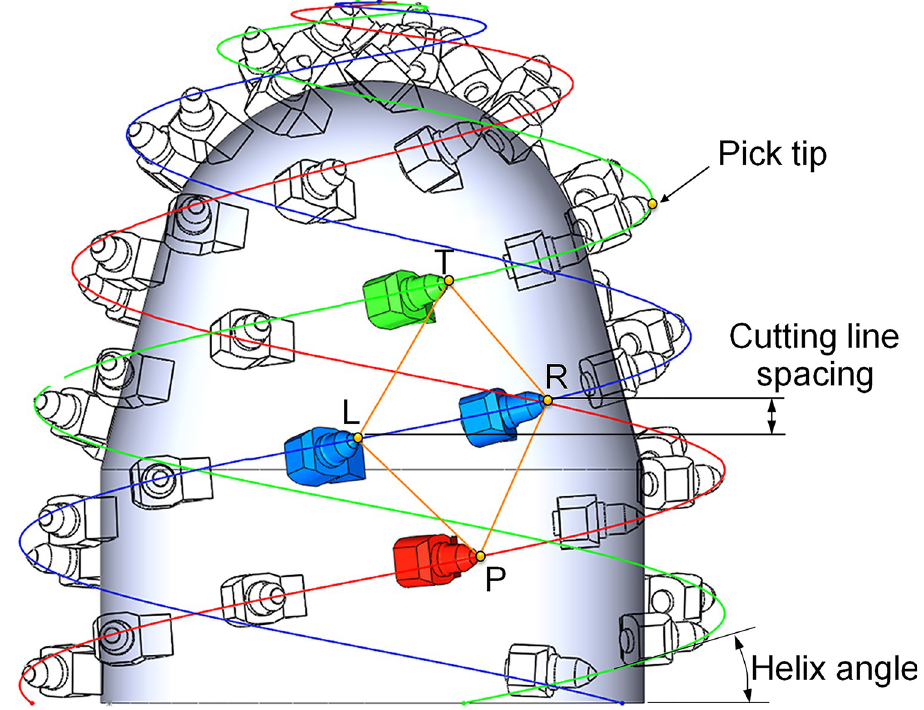
Fig 2. Mesh cell structure of Cutting